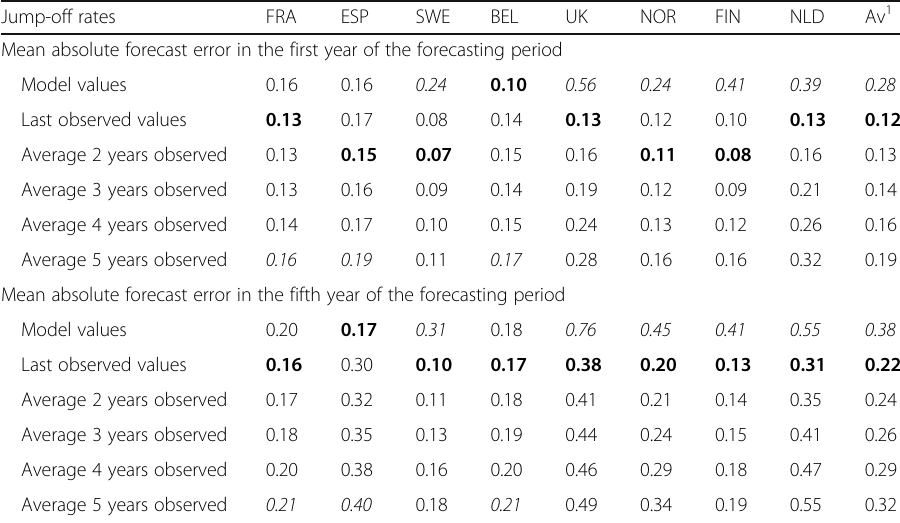
The lowest MAFE is marked in bold, the highest MAFE in italics 1 Unweigthed average of all eight